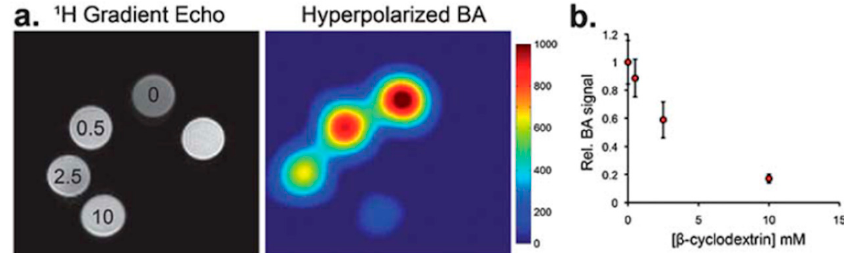
Figure 7. In vitro experiment at 14T demonstrating the potential application of β -CD as a contrast agent for hyperpolarized (HP) 13 C MRI. ( a ) Proton gradient echo image demonstrating the position of phantoms with a di ff erent concentration of β -CD (0–10 mM). The HP 13 C imaging was performed after the administration of 2.5 mM HP [1-13C] benzoic acid. It can be seen that the MRI signal decreases with β -CD concentration. ( b ) Relative MRI 13 C signal dependence on β -CD concentration [86]. The images are reprinted with permission from publisher [86]. DNP was used to create a CD contrast agent for DNP HP MRI [87]. Caracciolo et al. observed